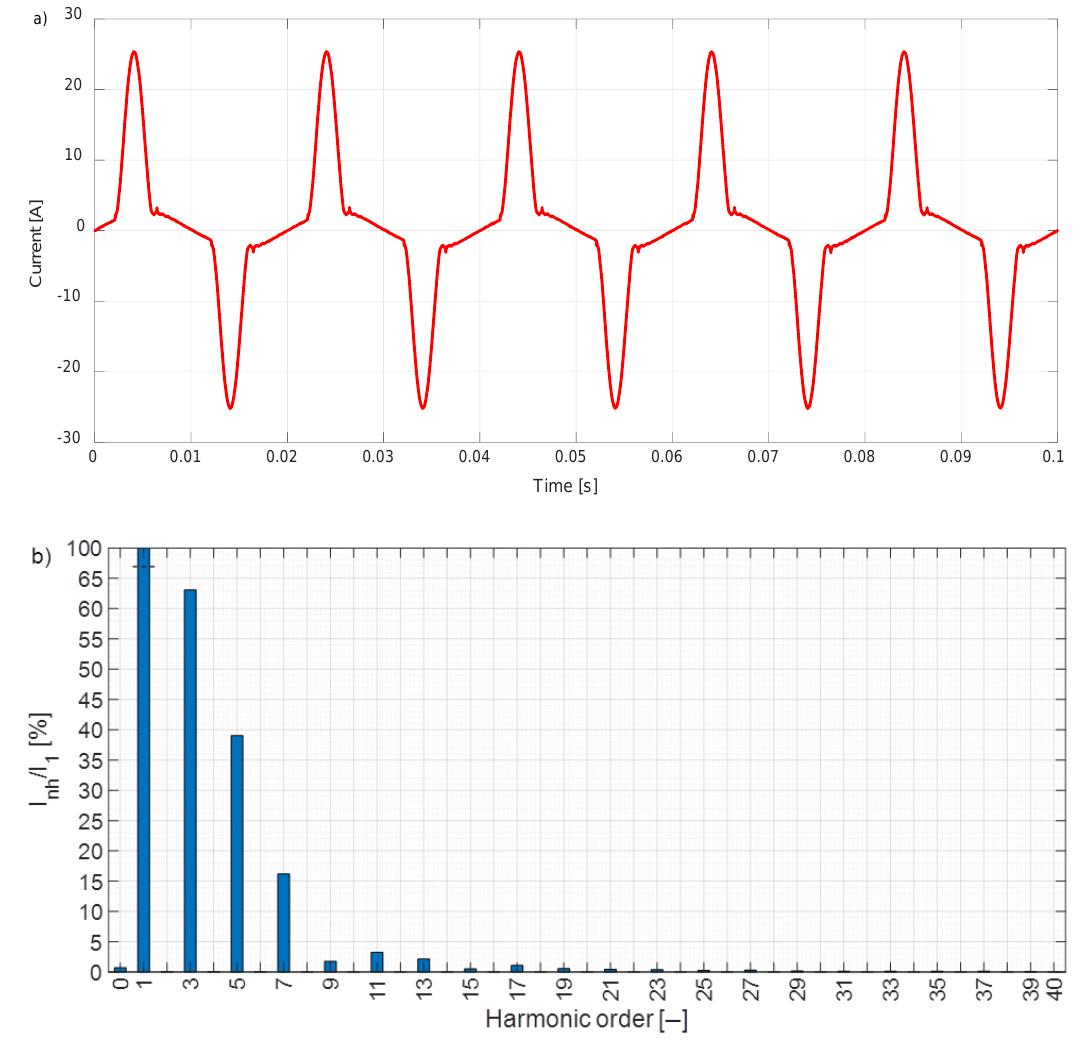
Figure 6. Examples of the measured results in the bridge rectifier load: ( a ) an example of the measured current waveforms and ( b ) their spectrum of harmonics.